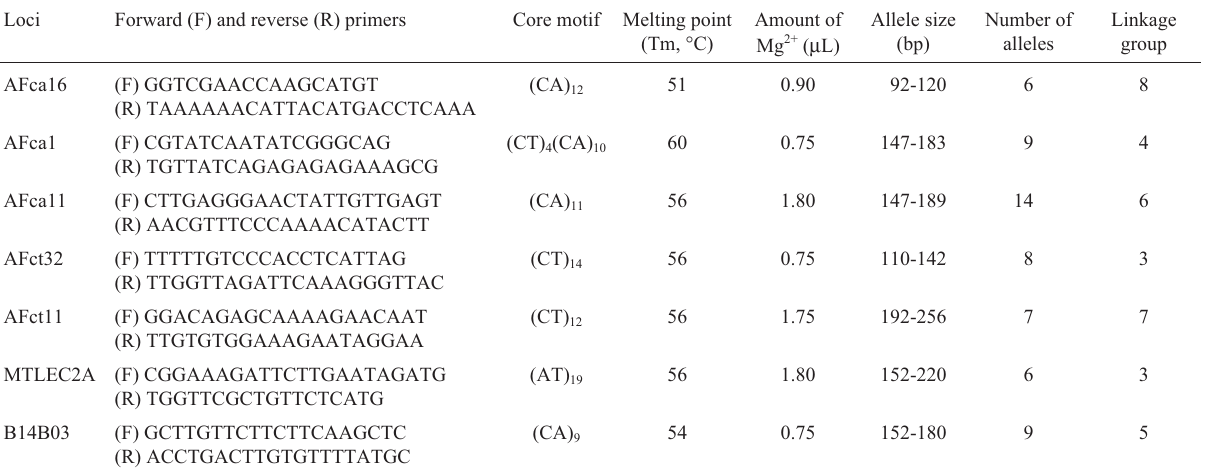
Table2 -Thesevenpairsofalfalfapolymorphicsimplesequencerepeat(SSR)primersusedinthisstudy.Notethatthenumberofallelesdoesnotinclude the null allele. Loci Forward (F) and reverse (R)